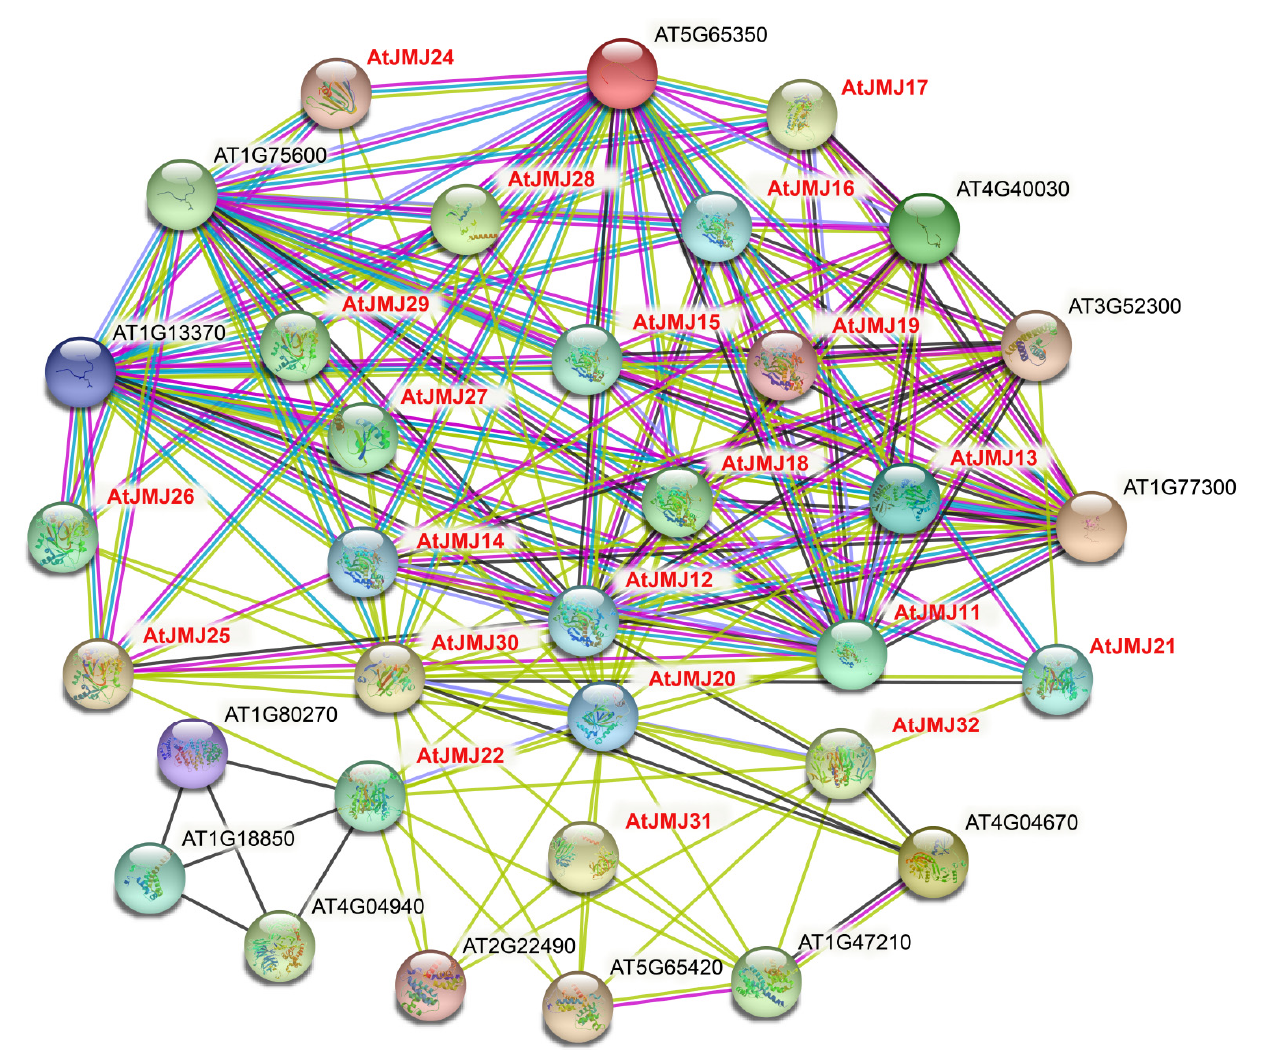
Figure 6. Functional network assembly of the A. thaliana JmjC proteins. Red letters are the A. thaliana protein. Light blue and purple lines represent known interactions determined by the database and experiments, respectively. Green, red, and blue lines represent predicted interactions from gene proximity, fusion, and symbiosis, respectively. Light green, black, and gray lines indicate other interactions from text mining, co-expression, and protein homology, respectively. Empty nodes: proteins of unknown three-dimensional structure. Filled nodes: some three-dimensional structures are known or predicted.